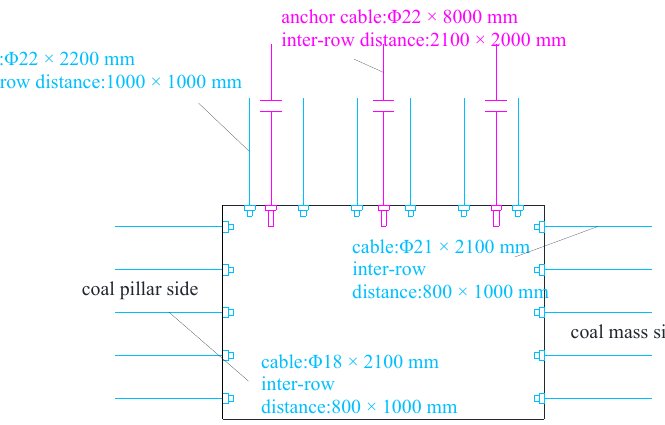
Figure 2. Initial support measures of mining roadway in 42202 stope.